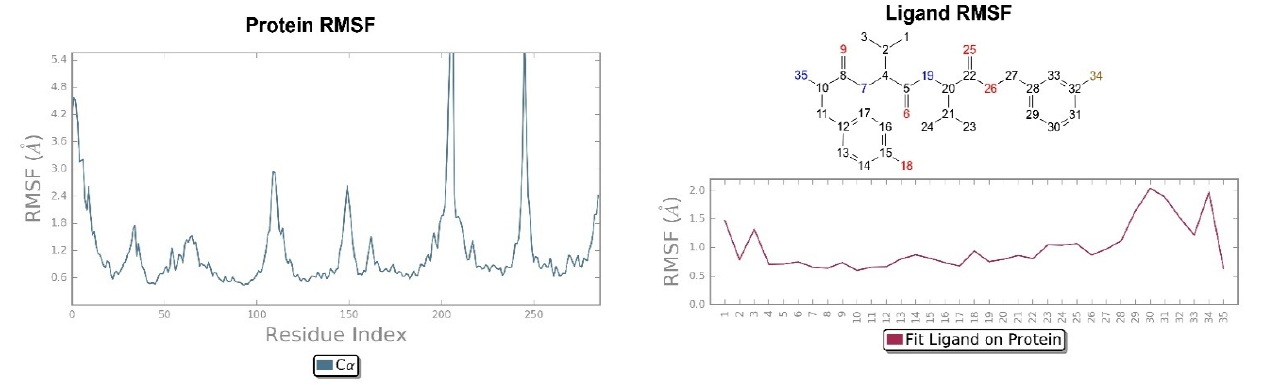
Figure 9. On the left: P-RMSF, KOR; on the right: L-RMSF of H-D-Tyr-Val-Val-O-(3-Br)-Bz ( 6 ).